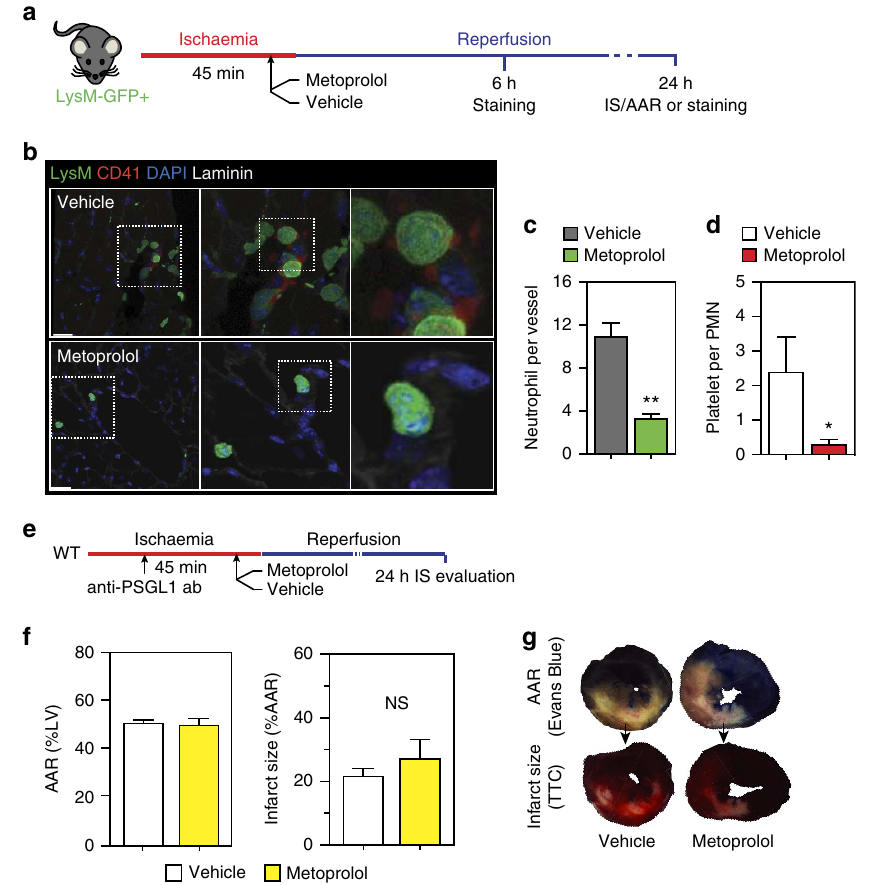
Figure 6 | Metoprolol inhibits neutrophil–platelet interactions. ( a ) Experimental scheme and representative confocal images evaluating the effect of metoprolol on the number of co-aggregates of neutrophils (LysM-GFP þ , green) and platelets (CD41, red) in the post-reperfused mouse myocardium. ( b , c ) LysM-GFP þ cells (neutrophils) attached to coronary vessels ( n ¼ 7–9) and the numbers of interacting platelets (CD41 þ ) per neutrophil in reperfused myocardium. Scale bar, 20 m m. ( d ) Protocol scheme for the IR experiment evaluating the effect of neutrophil-platelet blockade with anti-